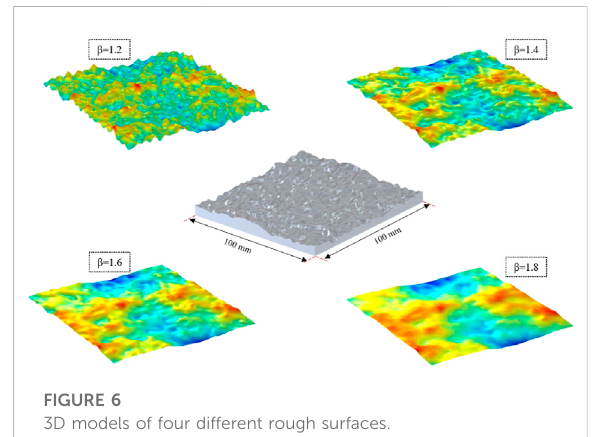
FIGURE 6 3D models of four different rough